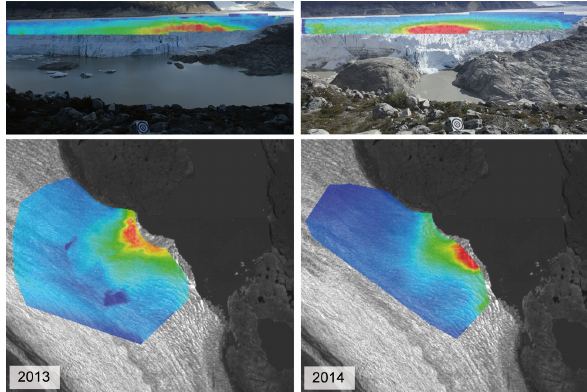
Figure 10. Location of the tunnel entrances during the GLOF events in 2013 and 2014. (Source: GeoEye: